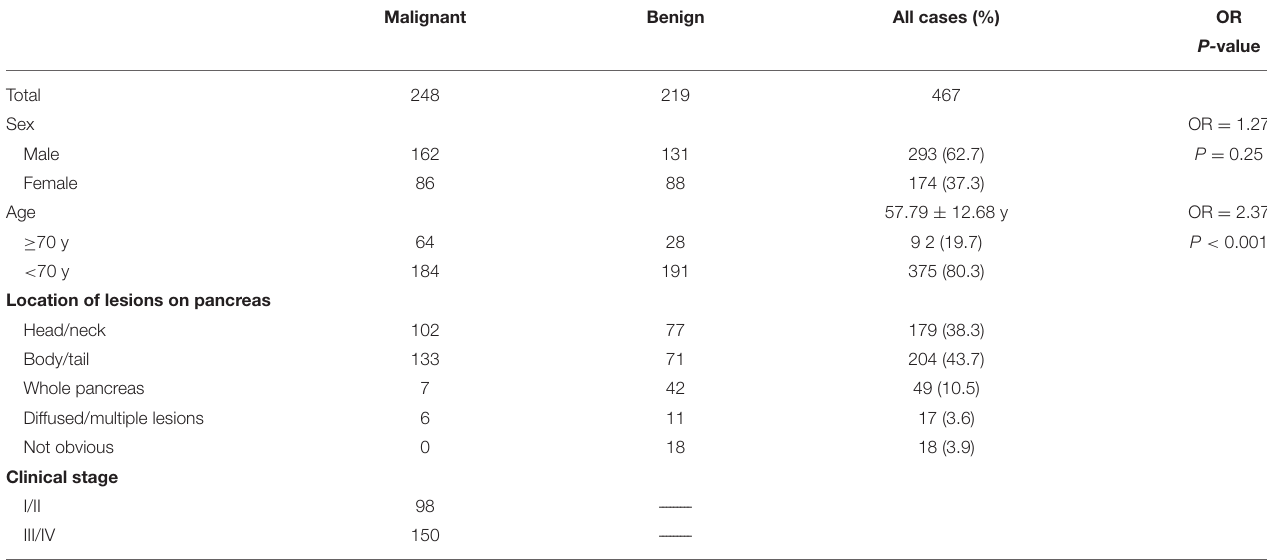
TABLE 1 | General characteristics of cases.